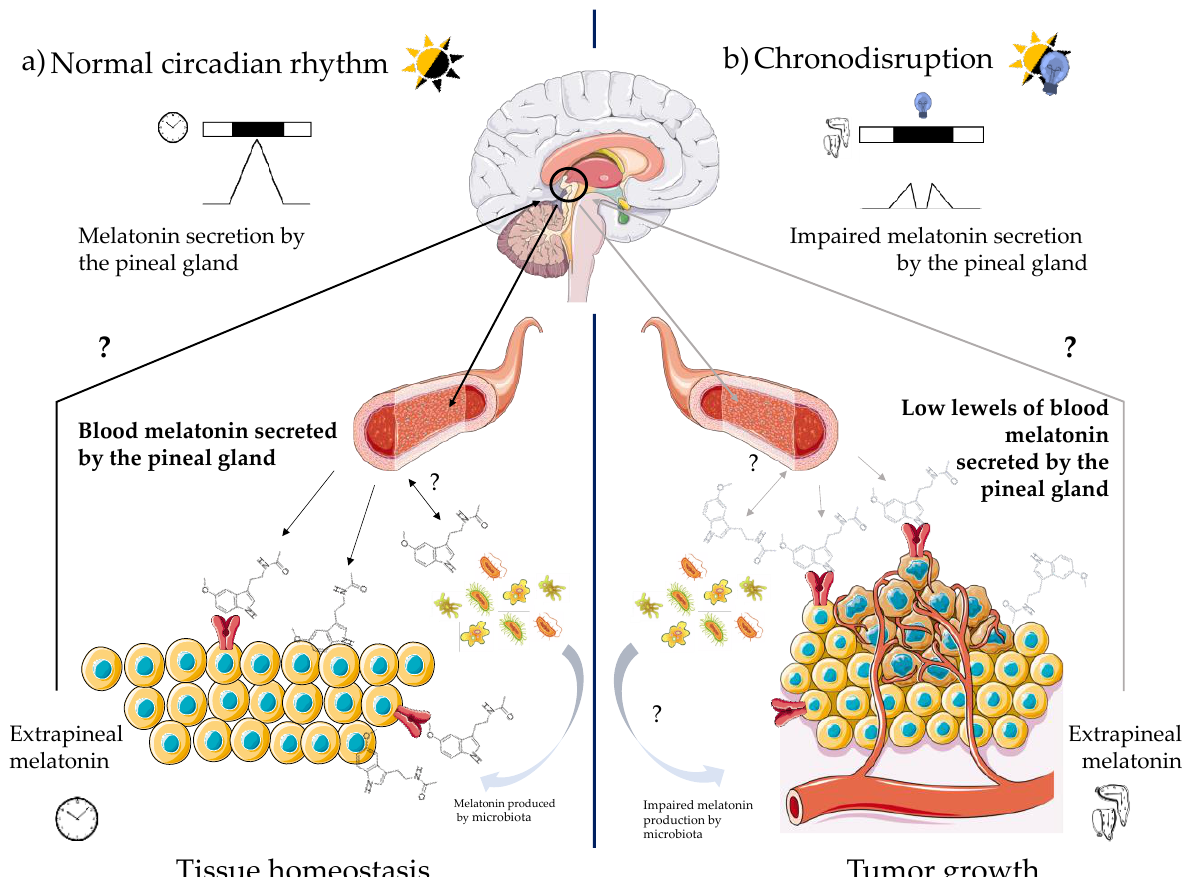
Figure 5. Possible interplay between pineal and extrapineal melatonin (chemical formula in grey) in chronodisruption. ( a ) Situation under normal circadian rhythm. The pineal gland secretes melatonin with a peak during the dark phase, reaching concentrations of 0.5–1 nM in plasma. Its actions may occur in an MT receptor-dependent manner or by diffusion through the plasma membrane. In addition, extrapineal melatonin seems to be in antiphase with melatonin from the pineal gland (concentrations not yet fully stablished). Plasma melatonin may participate in the regulation of extrapineal melatonin production (e.g., melatonin produced by the microbiota or different tissues) and, in turn, extrapineal melatonin may exert some regulation on the pineal melatonin secretion, thus closing a possible feedback-loop. ( b ) Under chronodisruption or ALAN exposure, melatonin secretion is impaired, probably with its total concentration reduced in plasma. When this situation is continued over time, it could affect the production of extrapineal melatonin, driving decreased or mistimed melatonin levels and therefore leading to peripheral clock mismatch and reducing the ability to control tumor growth. Another possibility that remains to be explored is whether the crosstalk between extrapineal and pineal melatonin is affected by chronodisruption, driving a malfunction of the feedback loop and contributing to the further promotion of the tumor. This figure was built with SMART resources (Servier Medical Art), licensed under a Creative Common Attribution 3.0 Generic License. See http://smart.servier.com/.